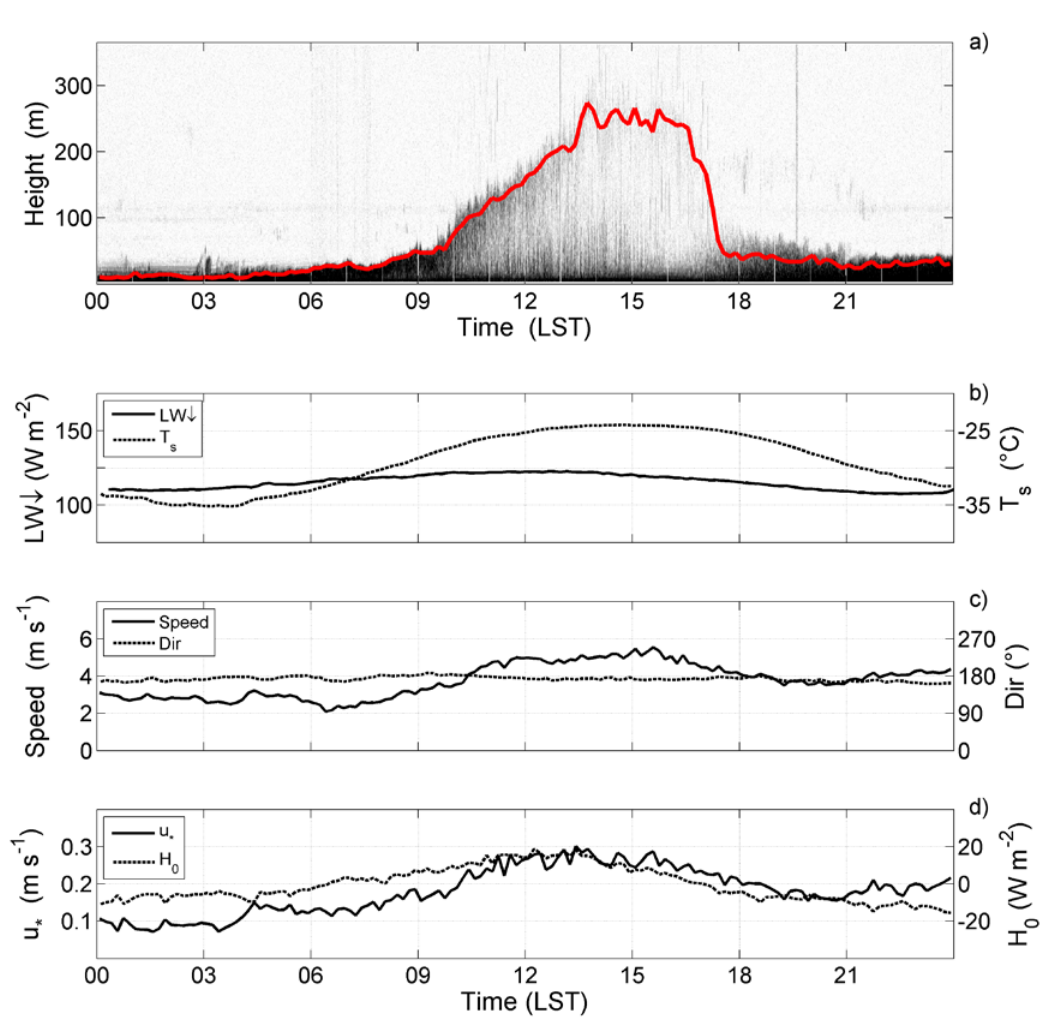
Figure 1 . Sodargram for 28 December 2011 with mixing height estimate (straight line) (a), downwelling longwave radiation ( ) and sonic temperature ( ) and heat fluxes ( 𝐿𝑊 ↓ 𝐻 0